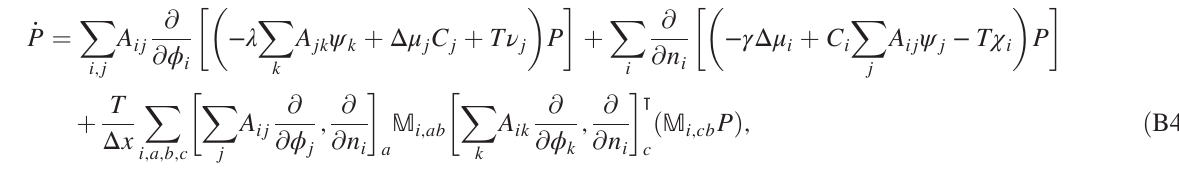
ffiffiffiffiffiffiffiffiffiffiffiffiffiffiffi γλ − C 2